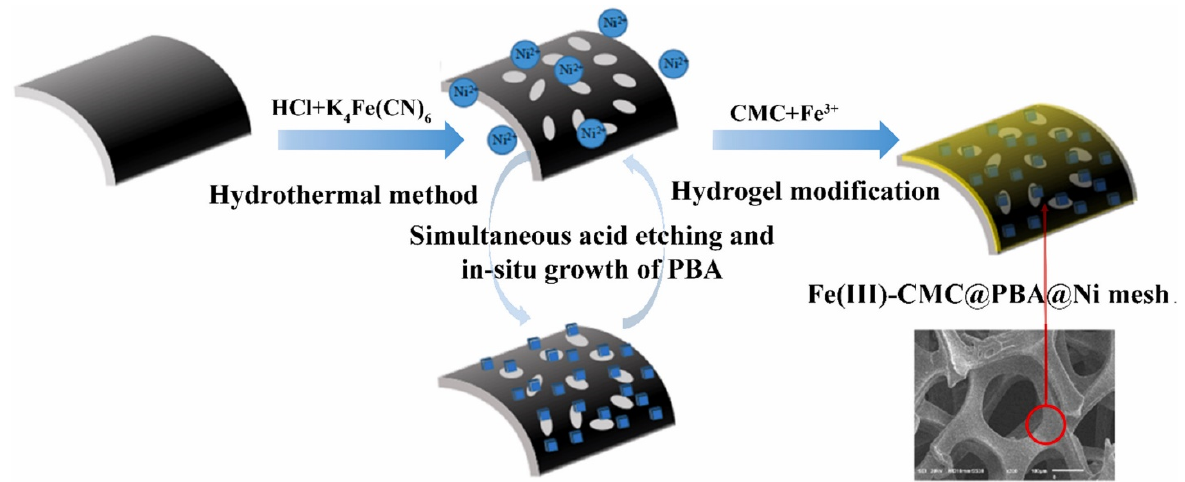
Figure 1. Illustration and SEM image showing hydrothermal deposition and hydrogel modification of the Fe(III)-CMC@PBA composite coating on nickel mesh for oil water separation. Reproduced with permission from [7], ©2021 Elsevier B.V.